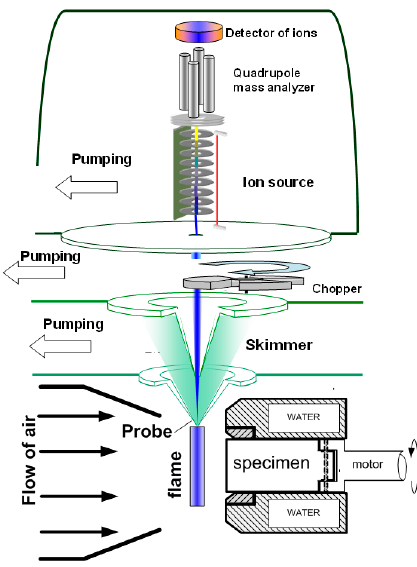
Figure 7 . Configuration of the experimental molecular ‐ beam mass spectrometric setup with a Figure 7. Configuration of the experimental molecular-beam mass spectrometric setup with a “soft” “soft” ionization system. ionization